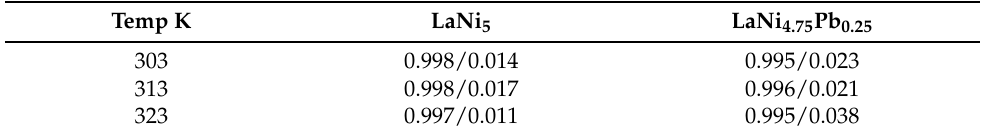
Table 2. Values of the regression correlation coefficient R 2 and the residual root mean square error (RMSE) for the fit of Model 2 to the experimental absorption isotherms. The values xx/yy correspond to R 2 /RMSE.